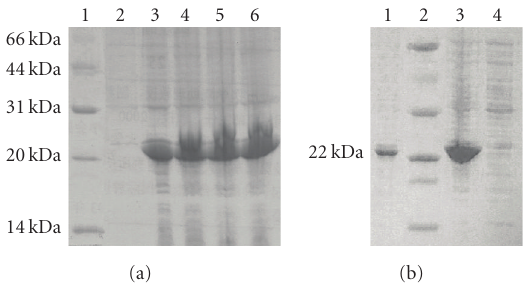
Figure 3: Expression analysis of recombinant VEGI-CTT in BL21(DE3). (a) Time course analysis of recombinant VEGI-CTT induction in BL21(DE3) induced by 1 μ M IPTG. Protein samples were prepared from the inclusion-body fraction of induced bacterial cells at time points of 2 hours (lane 3), 4 hours (lane 4), 6 hours (lane 5), and 8 hours (lane 6) of the induction, and were resolved on 12% SDS-PAGE. Lane 1: low molecular weight protein markers; lane 2: uninduced control. No di ff erence was found from lane 3 to lane 6 at 2–8 hours. (b) SDS-PAGE analysis of expression and location of the fusion protein VEGI-CTT in the cellular fractions of E. coli. Lane 1: eluted fraction under renaturing conditions with 500 μ M imidazole; lane 2: low molecular weight protein markers; lane 3: the inclusion-body fraction; lane 4: supernatant of cell